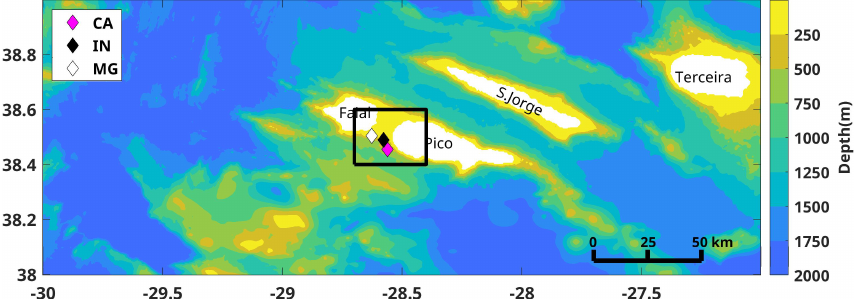
Figure 1. Azores archipelago central group: bathymetry according to GEBCO database [23]. The center box designates the area where the three acoustic recorders (CA, IN and MG) were